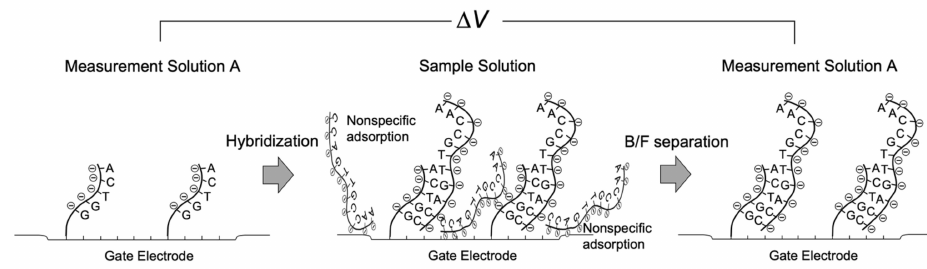
Figure 1. Schematic illustration of measurement process with